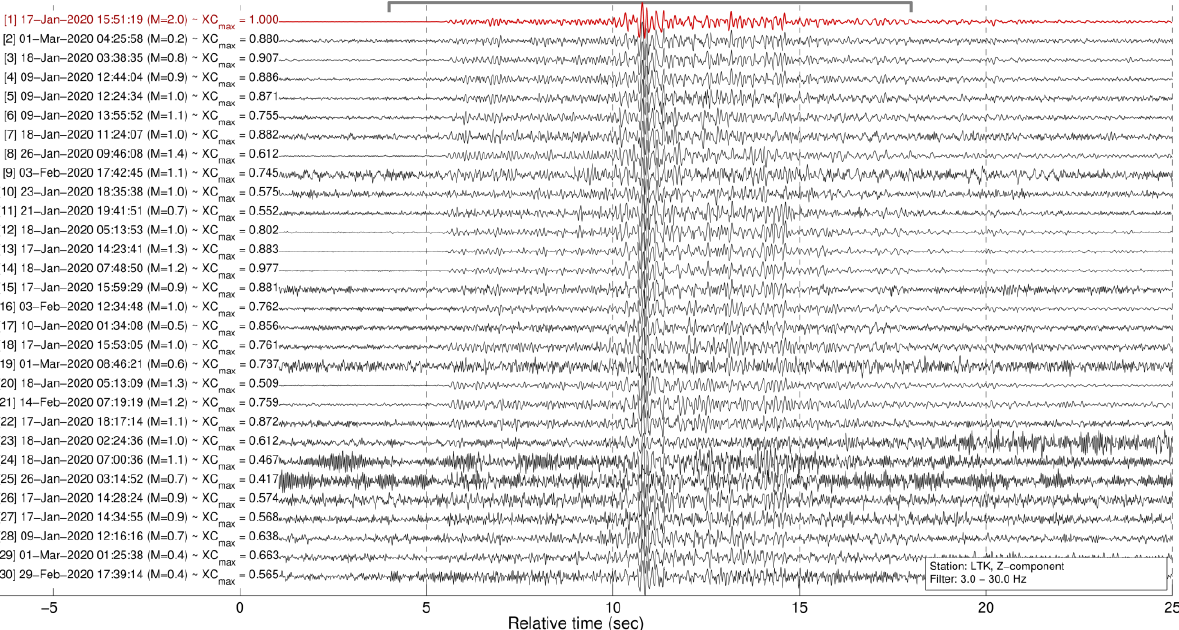
Figure A3. Waveforms of template “2020-01-17-15-51-20” (top, red) and 29 associated detections (black), belonging to multiplet #10 of CAT3, formed with farthest-neighbor linkage at a similarity threshold of 0.50. The recordings are from the vertical component of station LTK, filtered between 3 and 30 Hz. Events of this multiplet are associated with spatial group #6 (orange), about 27 km NW of station LTK, and particularly with a burst of activity on 17 – 18 January 2020. Note that the pre- sented XC max values are calculated for the purpose of this example and can be regarded as quite low when cross-correlation is performed between noisy records.